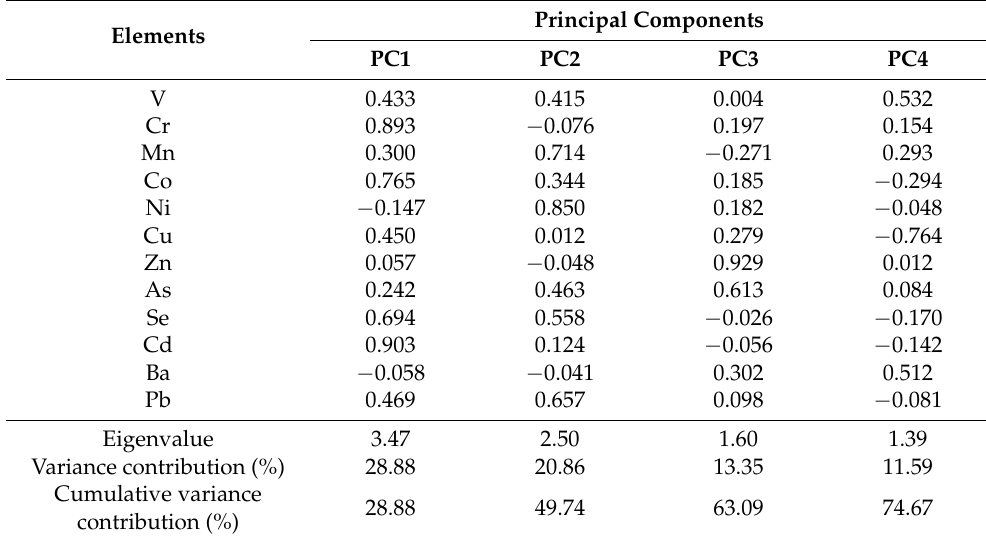
Table 5. Principal component analysis of overall road dust in